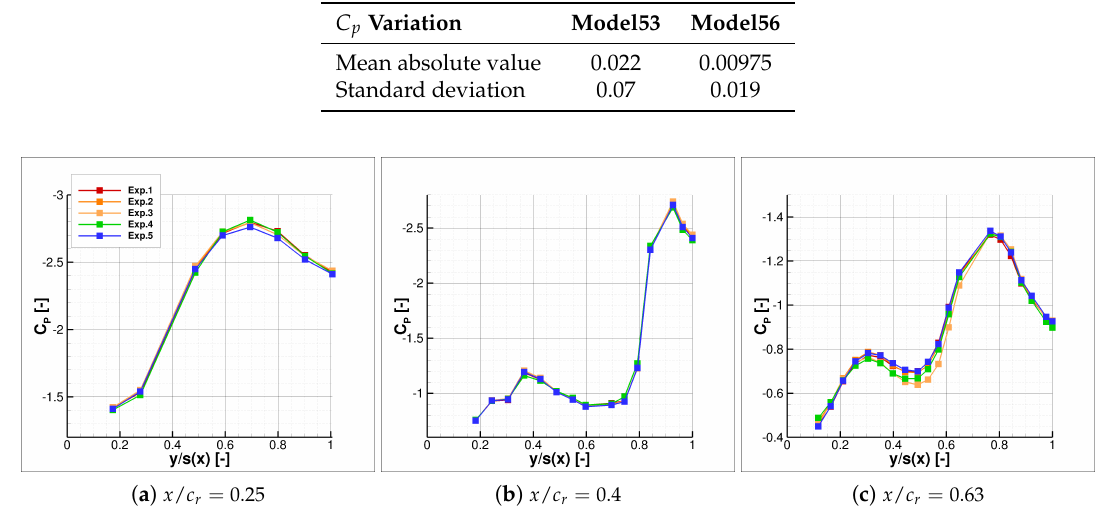
Figure 12. Surface pressure coefficient distribution, C p , for repeated measurements against local semi-span y / s at α = 25 ◦ for